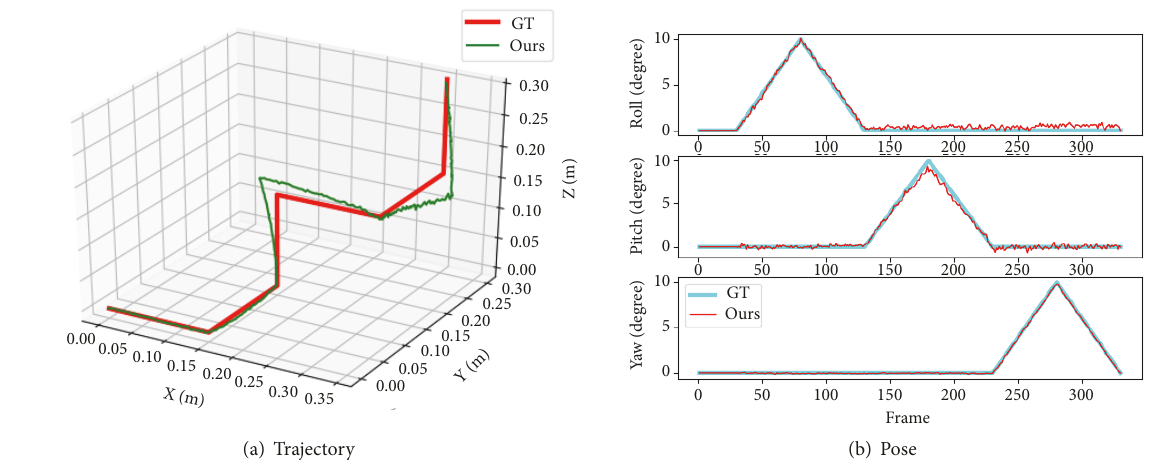
Figure 8: Comparison between the ground truth and our result on translate&rotate sequences.